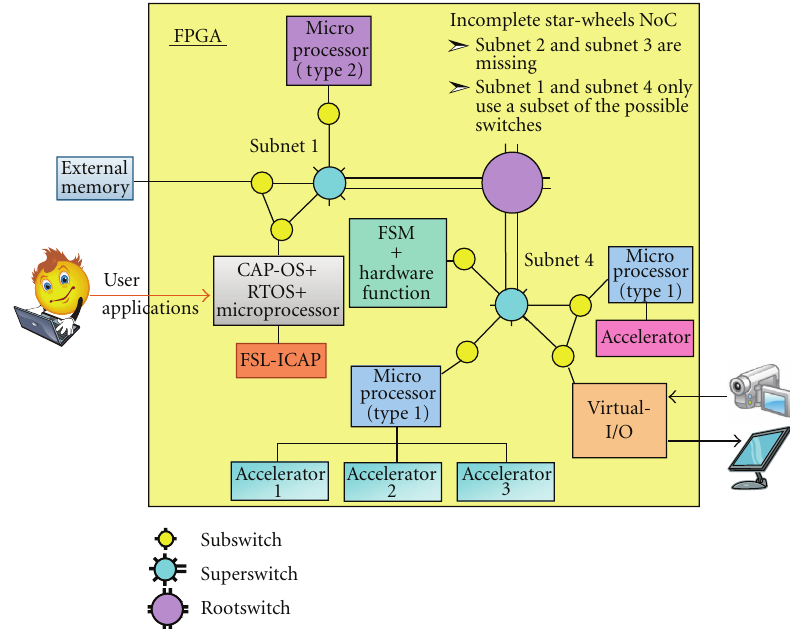
Figure 9: Integration of the CAP-OS on the